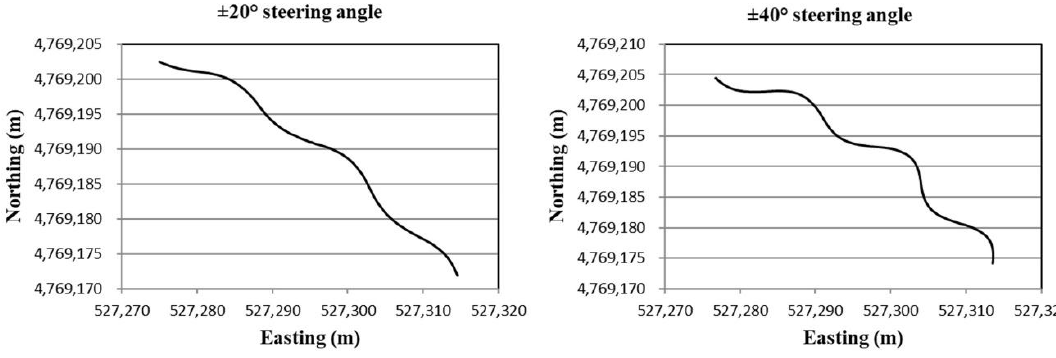
Figure 5. Sinusoidal trajectories of the tracked combine harvester at ±20° and ±40° input steering angles.